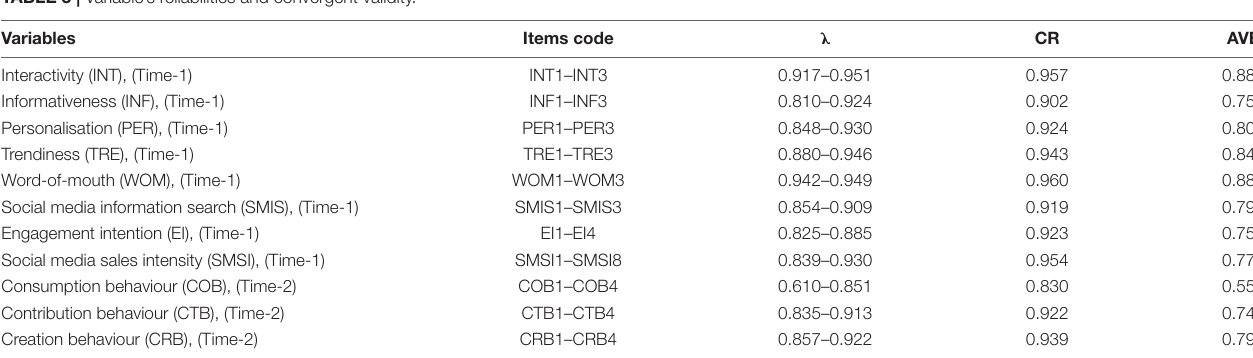
TABLE 3 | Variable’s reliabilities and convergent